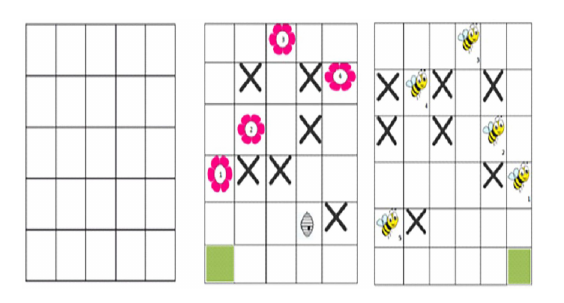
FIGURE 4 The three mats used in the research.